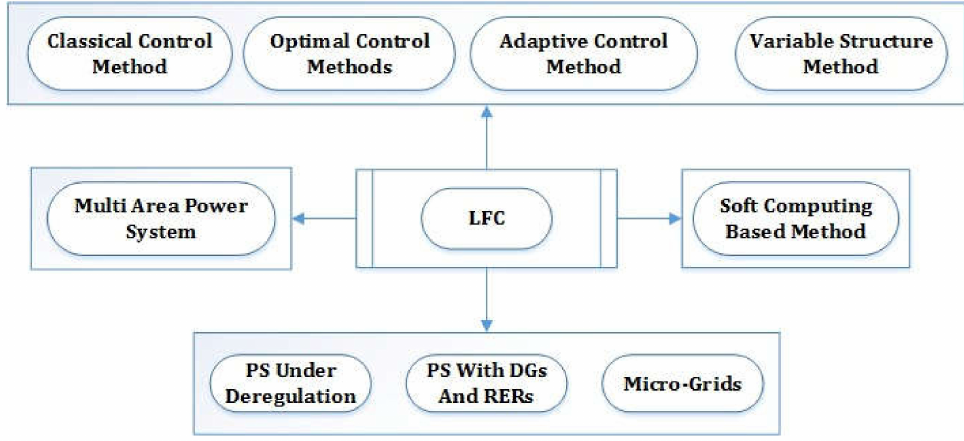
Figure 2. LFC in Different